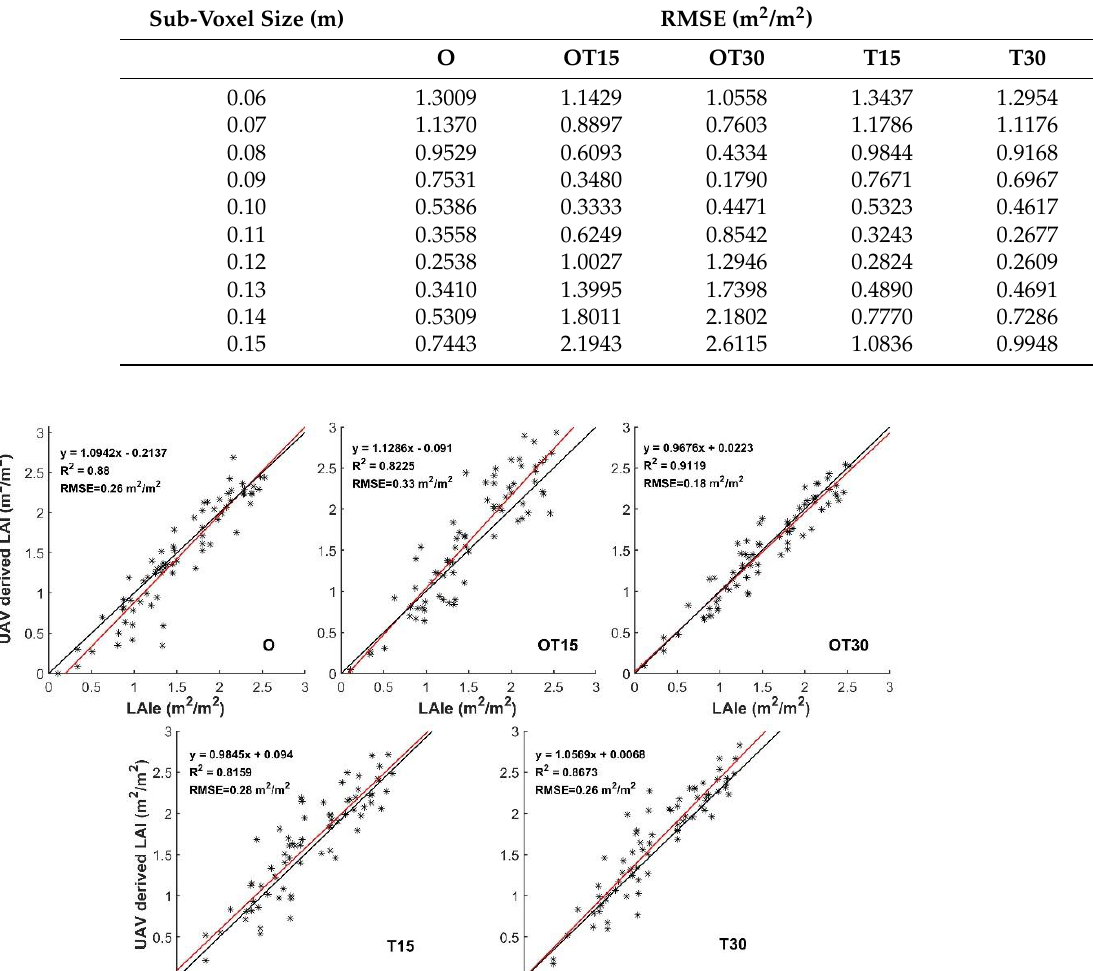
Table 2. Root-mean-square error (RMSE) (m 2 /m 2 ) between the LAI derived from five schemes and Figure 8. Root-mean-square error (RMSE) between the LAI derived from five schemes and effec- LAIe under different sub-voxel sizes. tive leaf area index (LAIe) under different sub-voxel sizes.